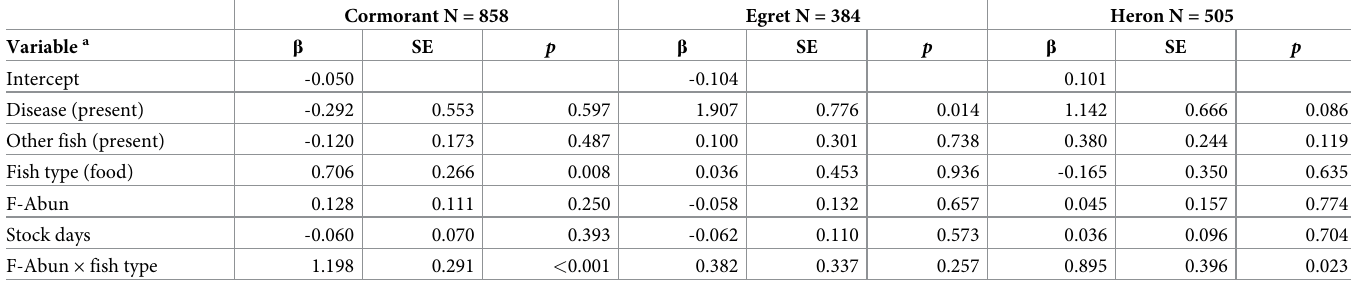
as invertebrates, amphibians, or reptiles [38]. For each of the study species, channel foodfish Table 6. Parameter estimates, standard error, and associated p-values for resource selection functions using logistic regression for cormorants, egrets, and herons use of catfish ponds in the Mississippi Delta. Presence data were collected by flying aerial surveys of catfish ponds, and variable data were collected on ponds randomly selected with and without the target